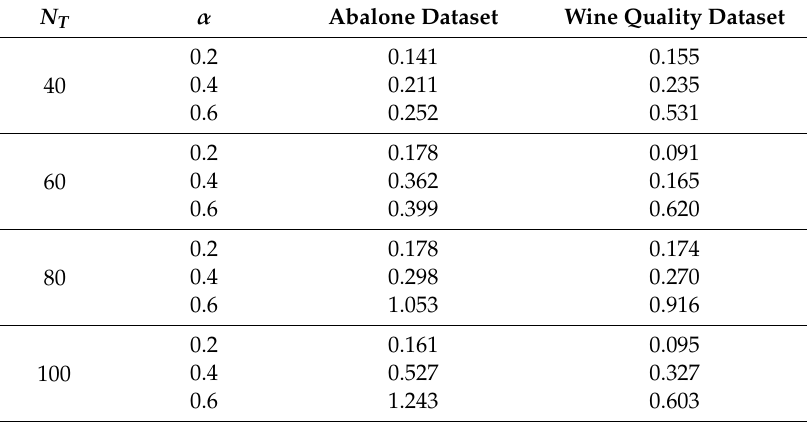
Table 7. Cohen (cid:48) s d using the proposed method and